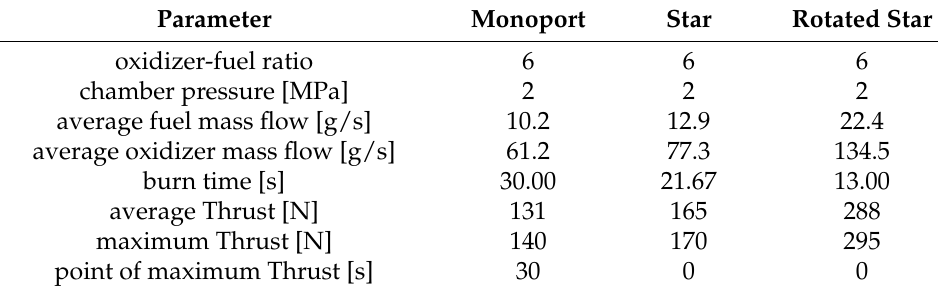
Table 4. Overview of the engine design parameters [15].